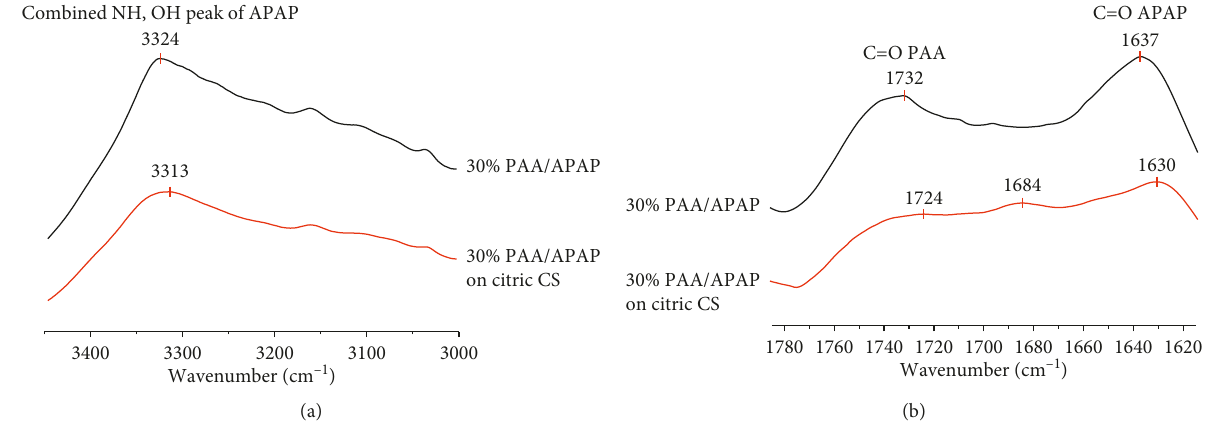
Figure 5: IR spectra of the PAA-APAP-citric CS system in the (a) combined N–H and O–H stretch region of APAP and (b) combined C � O stretch region of PAA and citric acid and C � O stretch region of APAP.